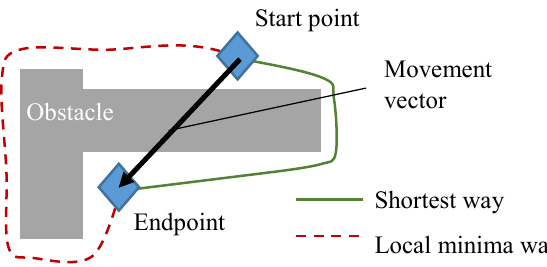
Fig. 4. Local minima trajectory example on surface On the other hand, the task of PM control is complicated by the facts that it is necessary to form a three-dimensional trajectory; there is no sensory data to obtain information about the surrounding space during the OD movement; and working at greater depths under water requires the formation of a more complex